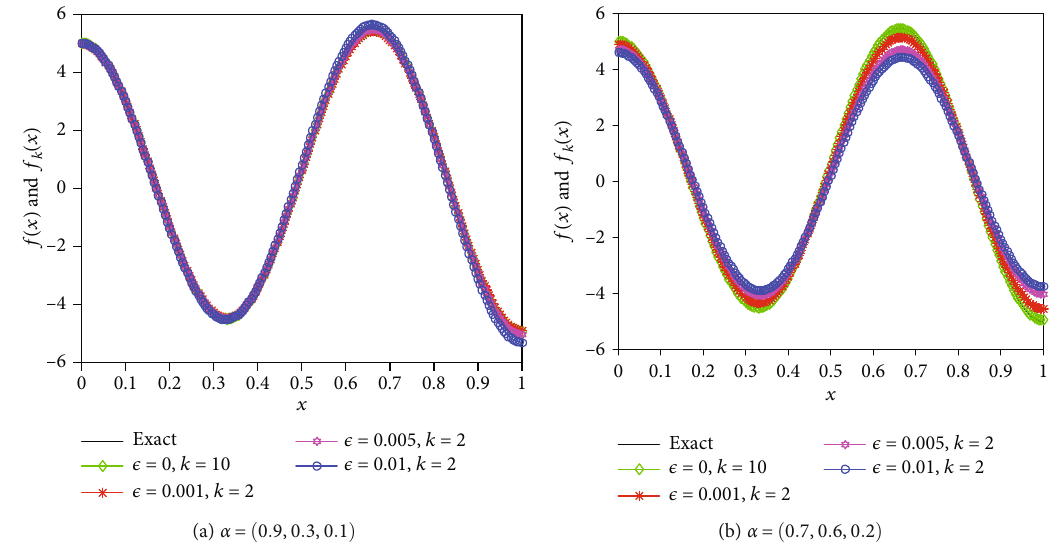
Figure 1: The numerical results for Example 16 for various noise levels with μ = 10 − 6 δ 3/4 and γ = 0 .